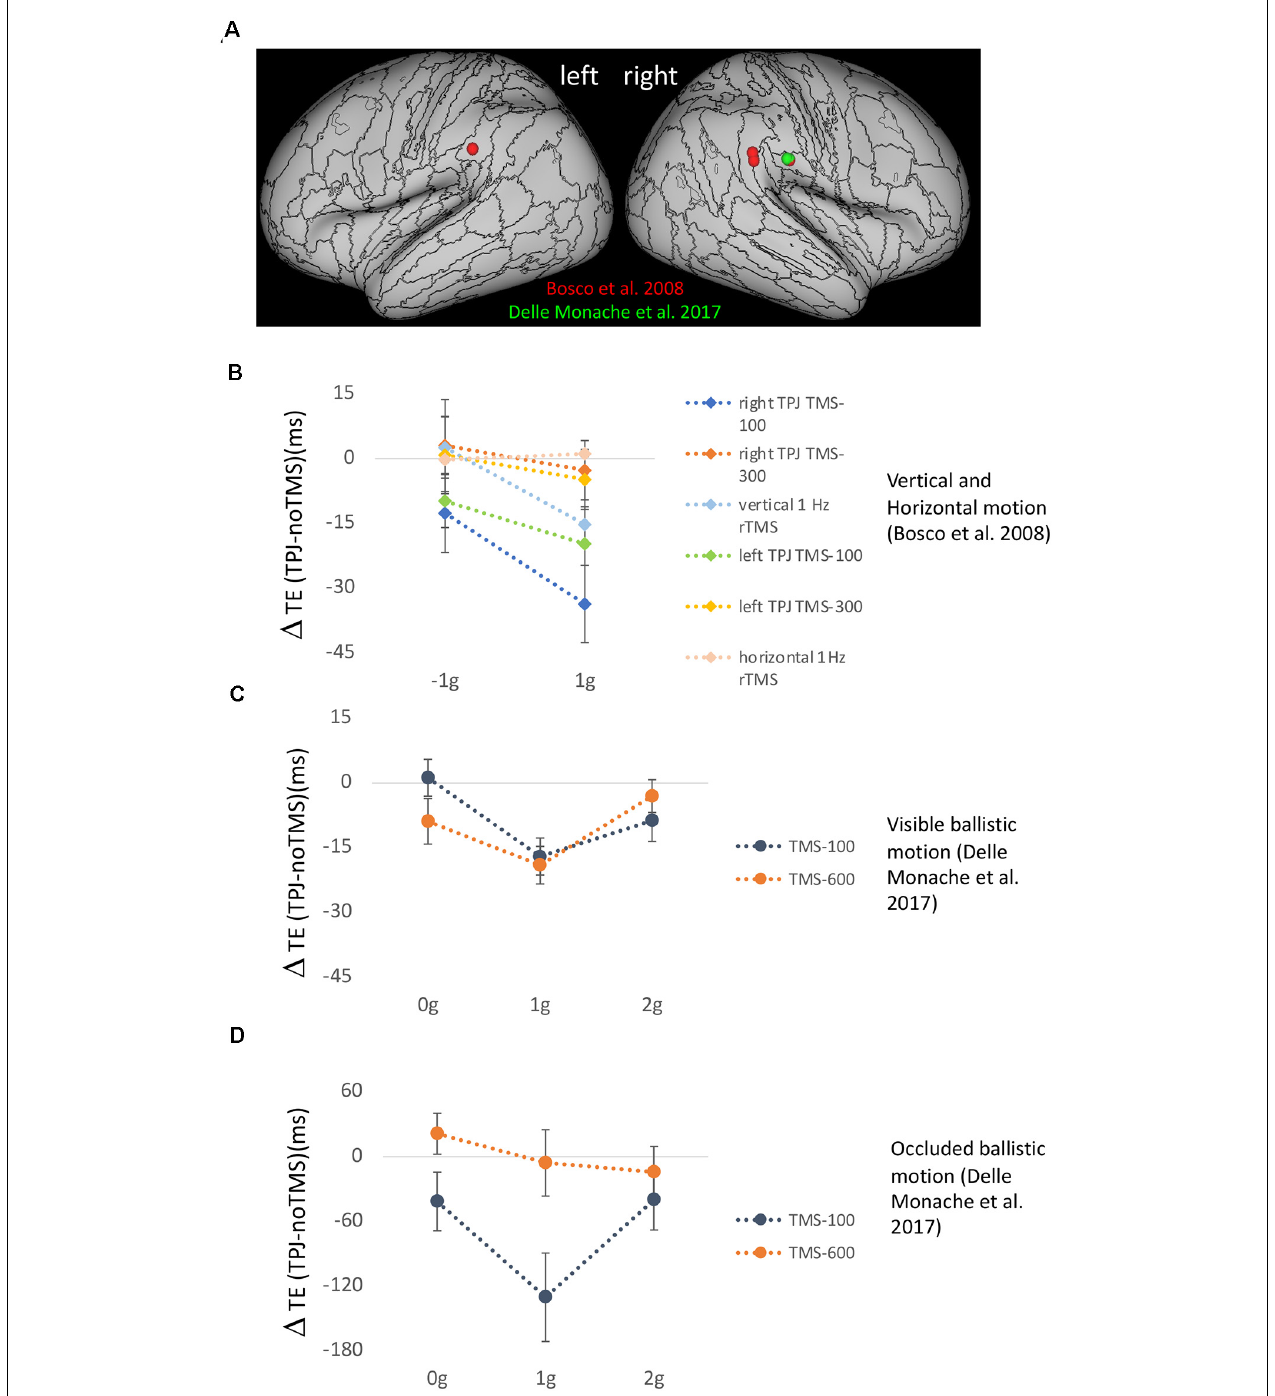
FIGURE 4 | (A) Effects of transcranial magnetic stimulation (TMS) of temporo-parietal junction (TPJ) on the timing of manual interception responses. (A) Anatomical location of the mean stimulation sites on TPJ reported for the experimental protocols of Bosco et al. (2008) (red) and Delle Monache et al. (2017) (green). (B) Mean timing error differences ( ± SEM) observed following TPJ stimulation compared to trials without TMS, for 1 g accelerated and decelerated motion in the six experimental protocols of Bosco et al. (2008). All conditions involved vertical target motion except that labeled horizontal 1 Hz rTMS. (C) Mean timing error differences ( ± SEM) observed following TPJ stimulation compared to trials without TMS for unperturbed 1 g and perturbed 0 g and 2 g ballistic trajectories, which were visible throughout their extent (Experiment 2 of Delle Monache et al., 2017). (D) Mean timing error differences ( ± SEM) observed following TPJ stimulation compared to trials without TMS, for unperturbed 1 g and perturbed 0 g and 2 g ballistic trajectories, which were occluded 500 ms after the perturbation until landing (Experiment 1 of Delle Monache et al., 2017).